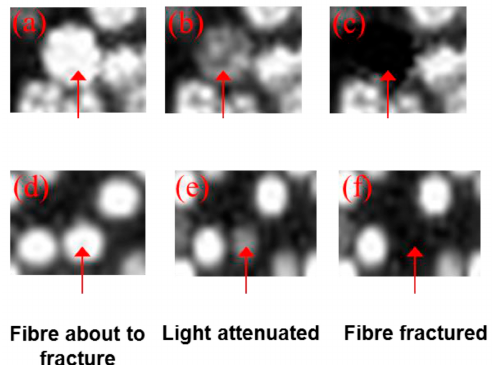
Figure 7. ( a – c ) Identification of imminent fibre fracture by monitoring the transmitted light intensity for a SDOF ( a , d ): whilst the sample was loaded in tension; ( b , e ) just prior to fracture; and ( c , f ) immediately after fibre fracture.